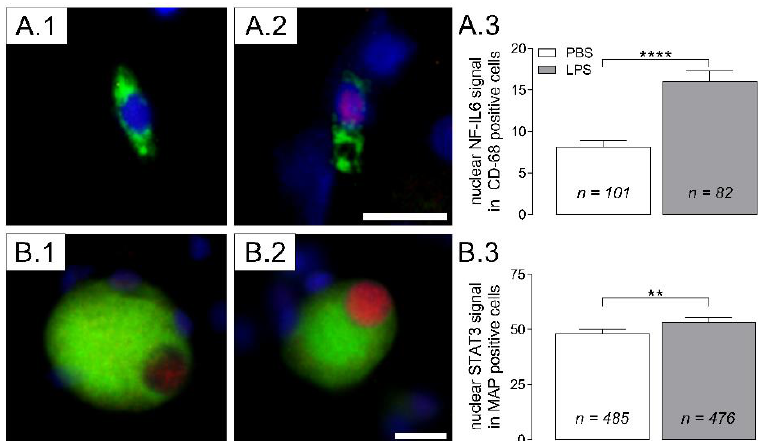
Figure 4. Nuclear translocation of inflammatory transcription factors nuclear factor interleukin 6 (NF-IL6) and signal transducer and activator of transcription 3 (STAT3) in cultured dorsal root ganglia (DRG) cells. Immunocytochemistry was performed in cultured DRG cells obtained from PBS- and LPS-treated rats to examine activation of inflammatory transcription factors. ( A ) In CD-68-positive macrophages (green) an enhanced nuclear signal of NF-IL6 (red) was detectable in rats treated with LPS ( A.2 ) compared to controls ( A.1 ). Calculating the mean nuclear intensity of the signal in the area of the nucleus (blue), a significant increase is detectable ( A.3 ). ( B ) The STAT3 signal (red) was mainly detectable in MAP-positive neurons (green) of DRG cultures of LPS-treated animals ( B.2 ) and controls ( B.1 ). Calculating the mean nuclear intensity of the signal in the area of neuronal nuclei (blue), a significant difference is detectable ( B.3 ). Bars represent the mean ± SEM. ‘ n ’ represents the number of investigated cells of the respective cell type. Scale bars present 10 µ m. **: p < 0.01; ****: p < 0.0001. PBS: phosphate buffered saline, LPS: lipopolysaccharide.